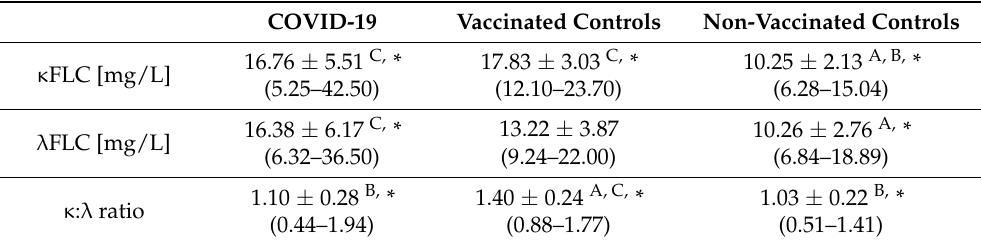
Table 3. The results of free light chains and κ : λ ratio in COVID-19 patients and healthy controls. Variable tested. Mean ± SD (min–max